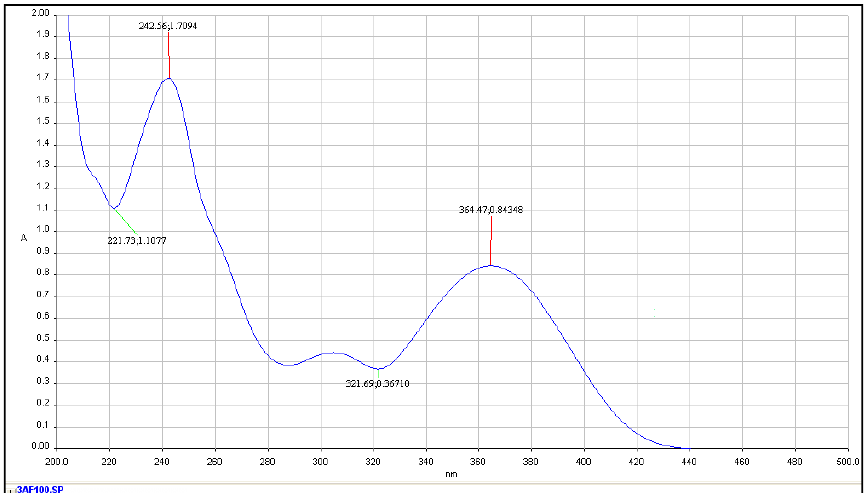
Figure 4. UV-Vis absorption spectrum of 3-aminoflavone in methanol at a concentration of 100 μ g/mL, in quartz cuvette with l = 0.2 cm, at temperature t = 20 °C, with methanol as the reference. The observed spectrum has three distinctive bands with maxima at λ = 364, 305 and 243 nm with molar absorption coefficients 10,005, 5220 and 20,277, respectively. It was confirmed that the spectra are stable over time for at least a few days.